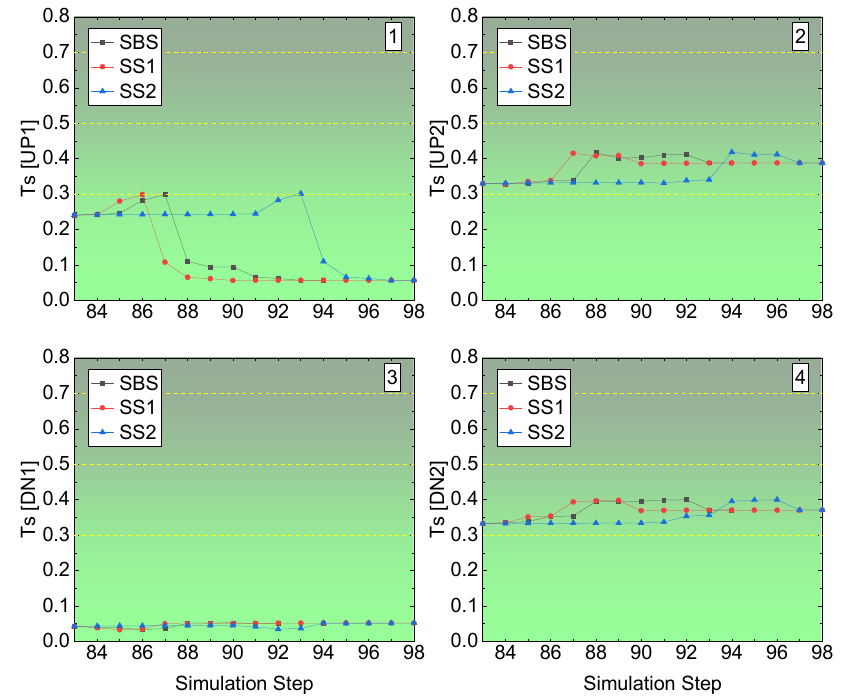
Figure 14. Ts value of the right-edge stope access to undercuts in Sill-1.